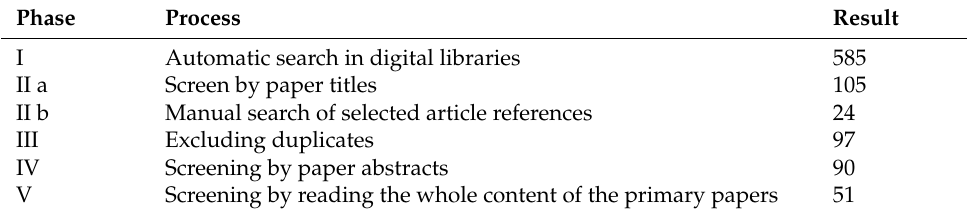
Table 4. Screening process for finding the relevant papers (Adapted from [46]).